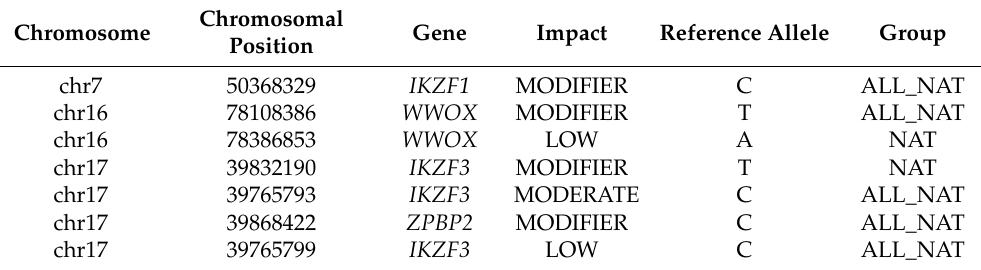
Table 1. The new gene variants identified in the Amerindian population investigated in the present study.